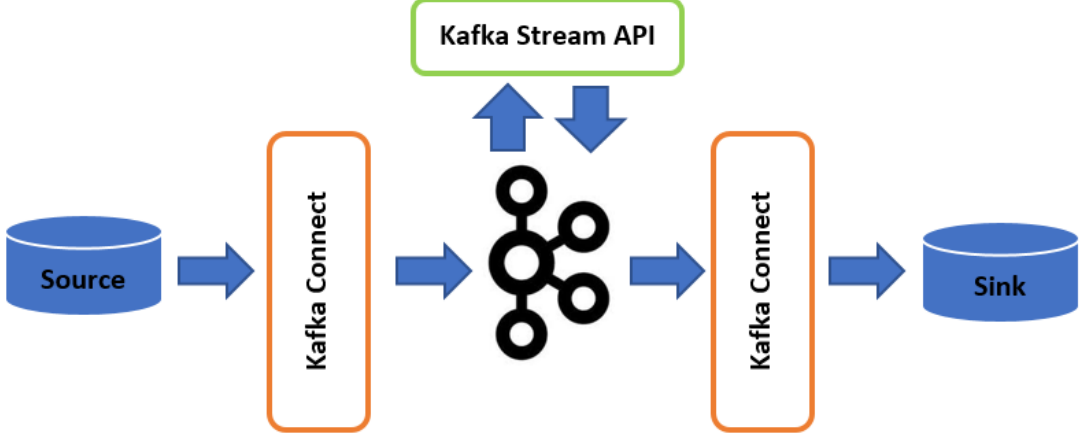
Figure 7. Overview of the Apache Kafka streaming engine [16].